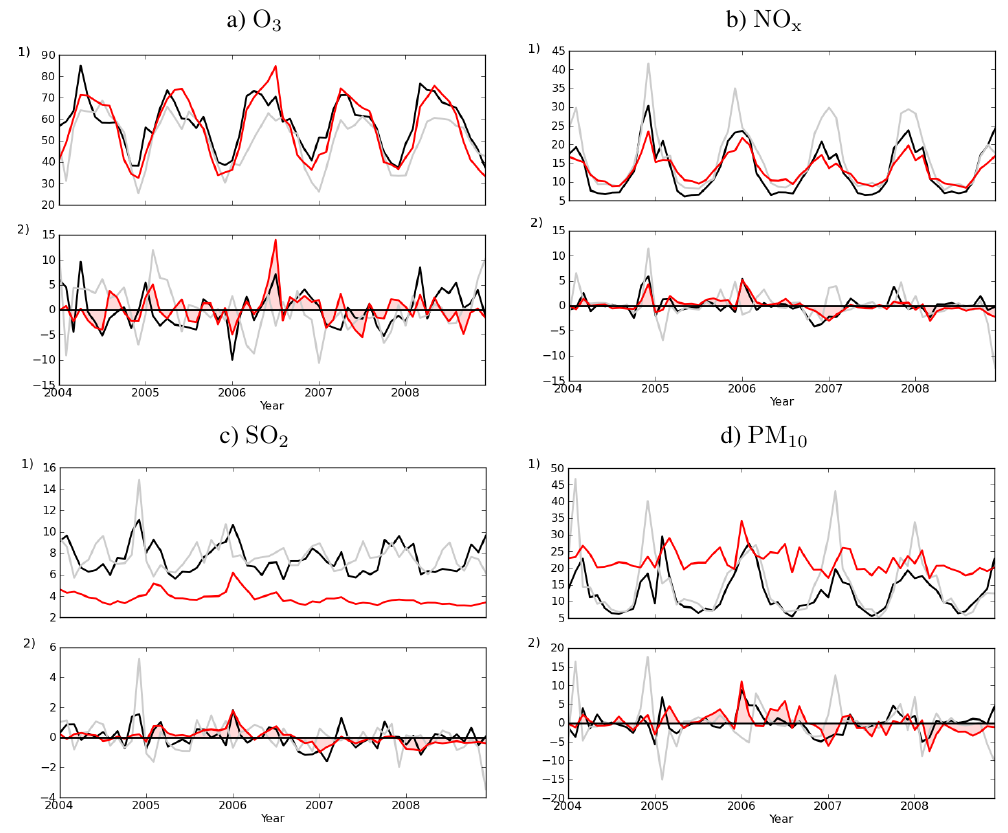
Fig. 10. (1) Simulated (ANALY: black lines; CLIM: gray lines) and measured (at the AirBase stations; red lines) time series of monthly Fig. 10. 1) Simulated (ANALY: black lines; CLIM: gray lines) and measured at the AirBase stations (red mean concentrations of O 3 (a) , NO x (b) , SO 2 (c) and PM 10 (d) . The time series are plotted from 1 January 2004 to 31 December 2008 and (a) , NO (b) , SO (c) and PM (d) . The time lines) time series of monthly mean concentrations of O 3 x 2 10 averaged over the European domain. Concentrations are in µg m − 3 . (2) Anomalies calculated when subtracting the average annual series series are plotted from 1 January 2004 to 31 December 2008 and averaged over the European domain. from the time series in (1). Concentrations are in µ g m − 3 . 2) Anomalies calculated when substracting the average annual series from Table 6. Seasonal and annual statistics obtained with MOCAGE over Europe at the AirBase stations. Statistics are averaged for the 5- the time series in 1). yr period. Summer: June, July, August and September; winter: December, January, February and March. The calculated statistics 48